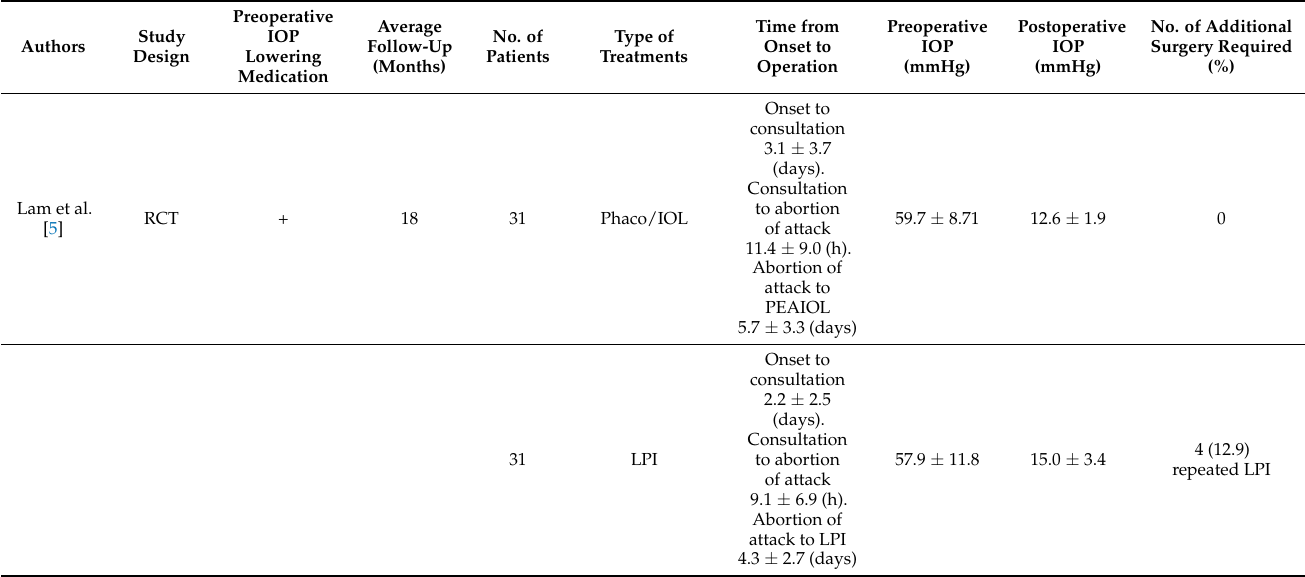
Table 5. Comparison between previous reports about PEA-IOL and our